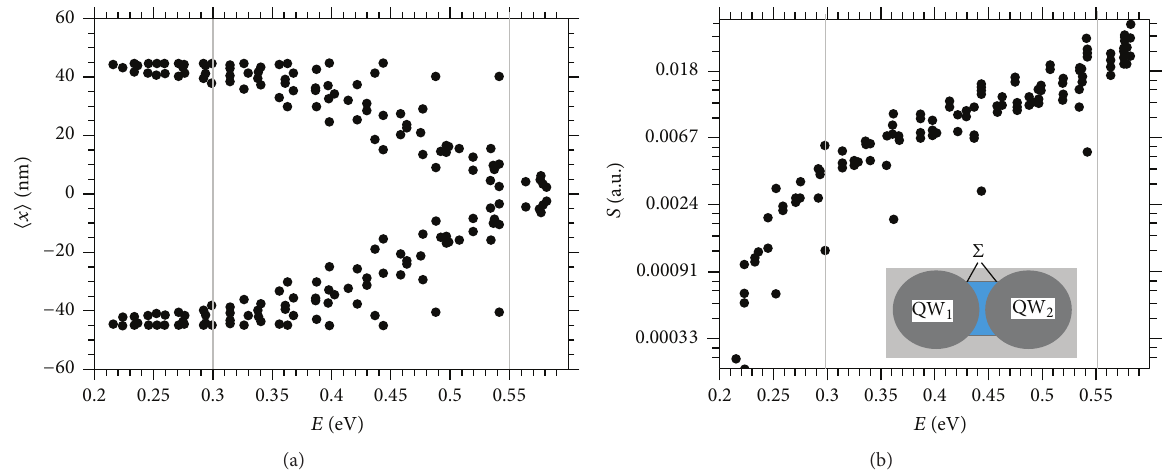
Figure 7: (a) Spectral distribution of ⟨𝑥⟩ for asymmetric DQW with 𝑎 = 10 nm. The asymmetry parameter 𝜉 = 𝑅 2 /𝑅 1 = 39.999/40 (𝜉 = 0.999975) .Theverticallinesdividethespectruminthreepredominantparts:delocalized,transitional,andlocalizedstates.(b)Overlapintegral 𝑆 plotted along electron spectrum; the integration area Σ is shown in the inset.